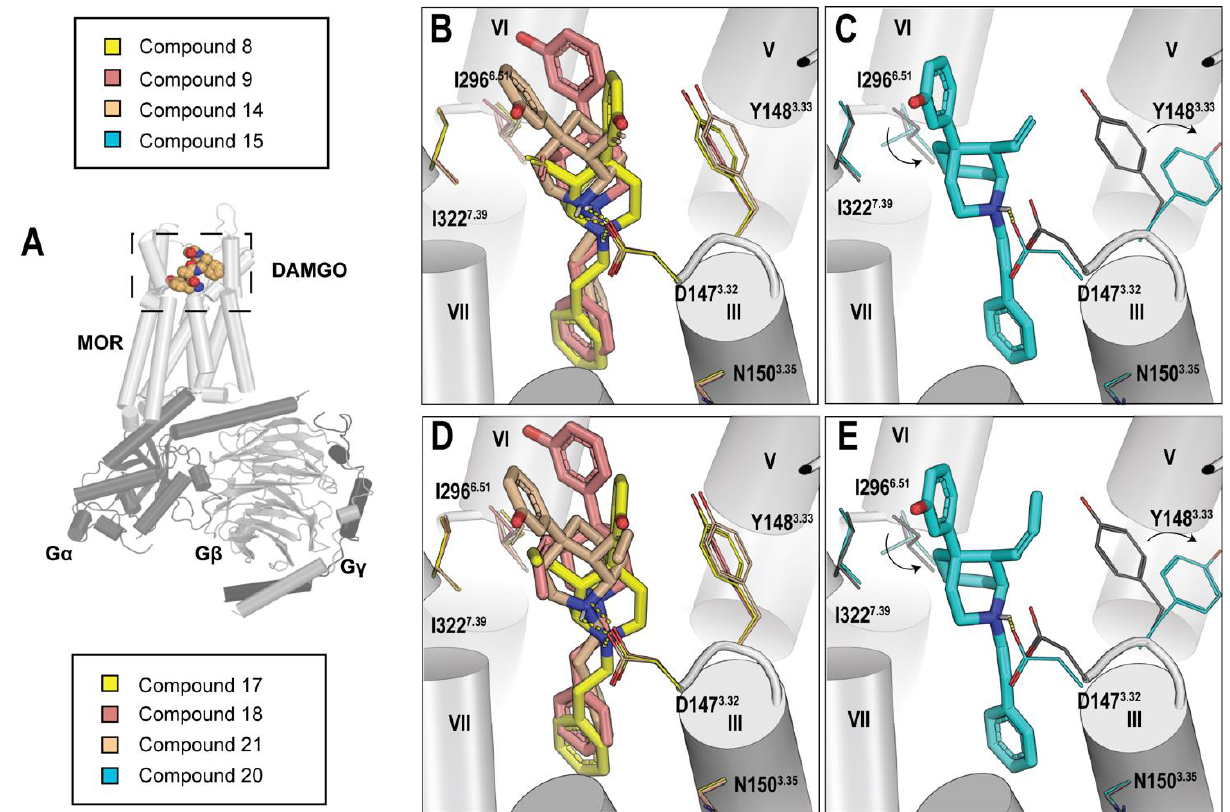
Figure 3. Representative docking poses of C9-substituted compounds in the active MOR. The C9- vinyl compounds 8 , 9 , 14 , and 15 are shown in ( B , C ) and the C9-propenyl compounds 17 , 18 , 21 , and 20 are shown in ( D , E ). A section of TM2 and TM3 were hidden to provide a better view of the binding site. ( A ) An overview of the DAMGO-bound MOR-Gi complex (6DDF). ( B ) The vinyl group of 8 (yellow) can form hydrophobic interactions with I322 7.39 . Due to the orientation of its vinyl group, 14 (tan) is unable to form this stabilizing interaction. ( C ) 15 (cyan) clashes with Y148 3.33 and I296 6.51 in the active cryo-EM receptor structure (gray), forcing these residues to adopt new configurations. Arrows show the movement of these residues from the initial active cryo-EM structure to the induced docking configuration. ( D ) The elongated substituent of 17 may form a stronger hydrophobic interaction with I322 7.39 . ( E ) The addition of a carbon to the vinyl group of the antagonist 20 (cyan) may make the clash with Y148 3.33 more extreme in the active cryo-EM receptor structure (gray).